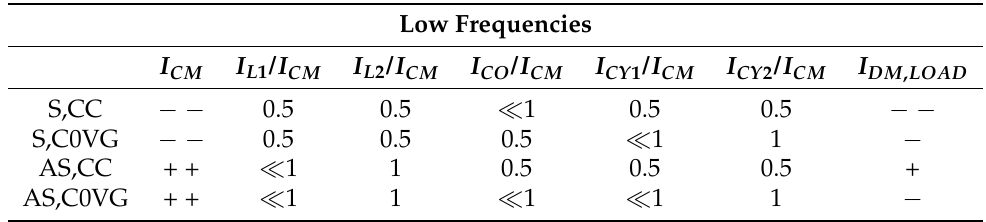
Figure 4. Model to predict CM to DM conversion in the proposed filter configurations, derived from the circuit model in Figure 2. Table 1. Comparison for the different filter configurations studied here of the magnitudes of the expected currents flowing at the output filter, as represented in the circuit model in Figure 4. This comparison assumes that the frequency is sufficiently low so as to make negligible the effect of parasitic